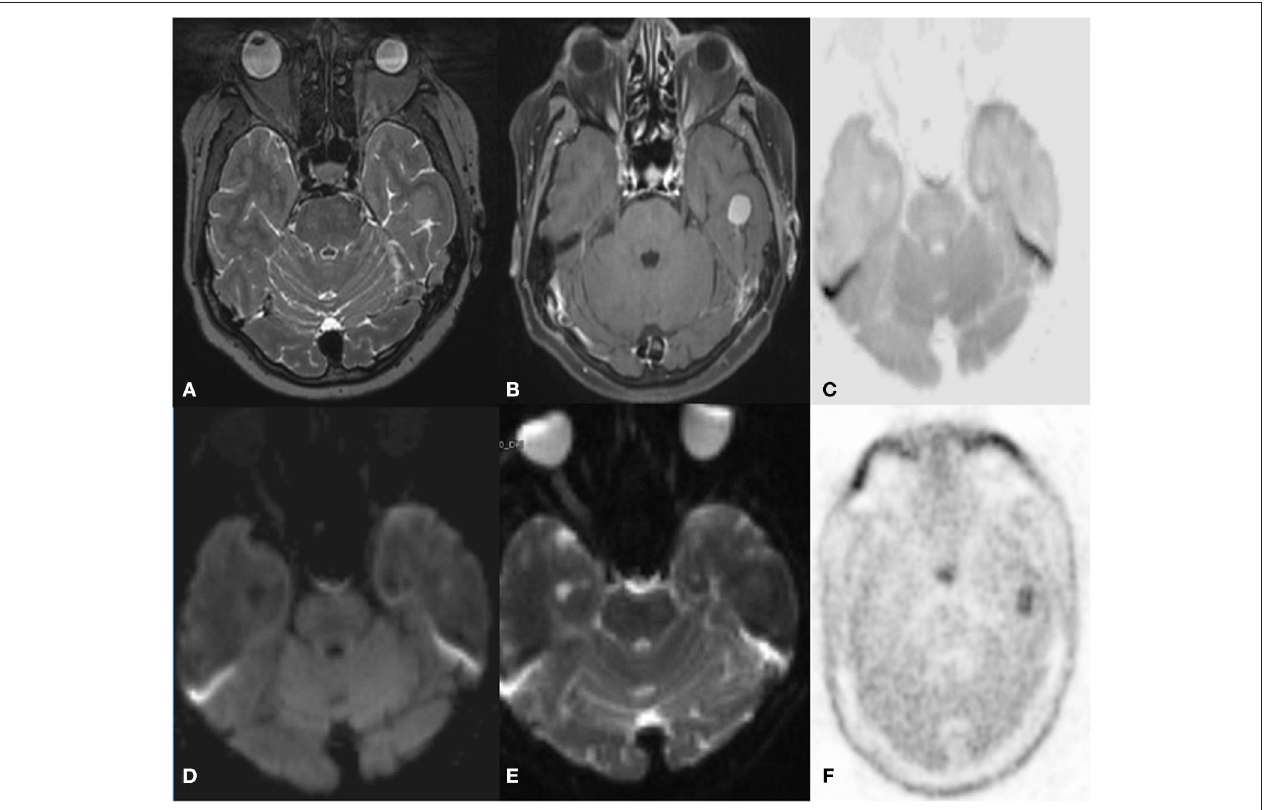
FIGURE 7 | A 59 year old female with Glioma, incidentally detected a lesion in follow up MRI C-11 Methionine PET axial images T2W (A) post-contrast T1 (B) Inverted DWI (C) DWI b2000 (D) ADC (E) NAC PET (F) shows a broad-based T2 hypointense intensely enhancing in the left inferior temporal convexity. The lesion shows no DWI restriction with hypermetabolism on PET. S/O meningioma. False-positive uptake of meningioma by